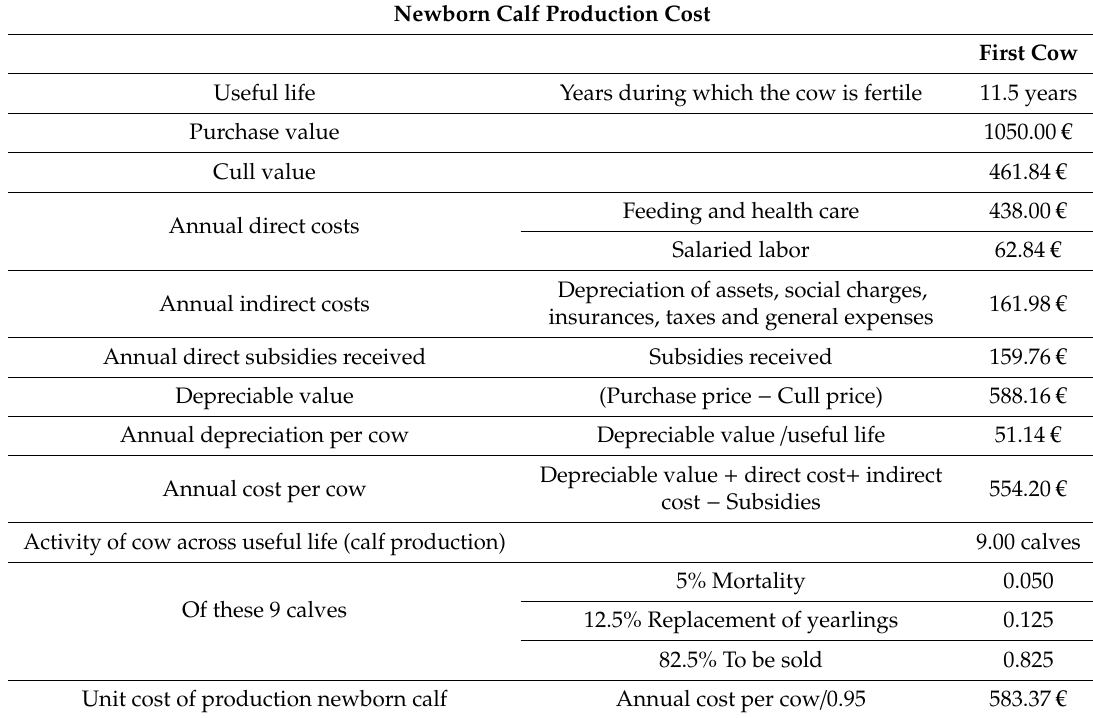
Table 2. Cost of production for a newborn